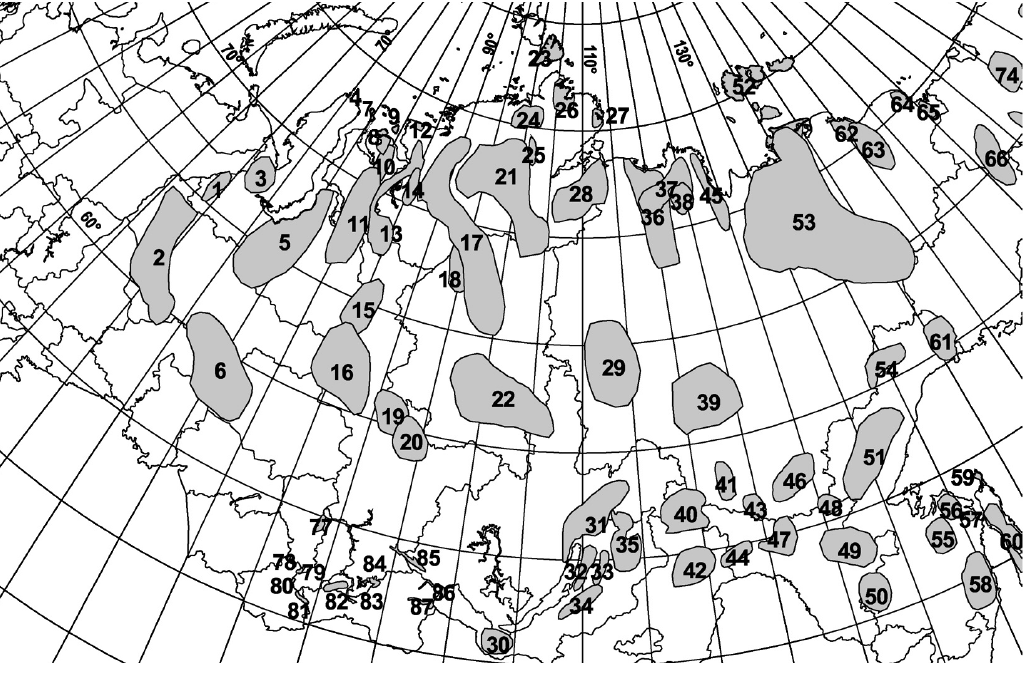
Fig. 2. Reindeer populations (Nos. 1-35 and 77-87) in Siberia (I.D. No. in figure correspond to the I.D. No. for popu- lations listed in Tables 1 and 2).